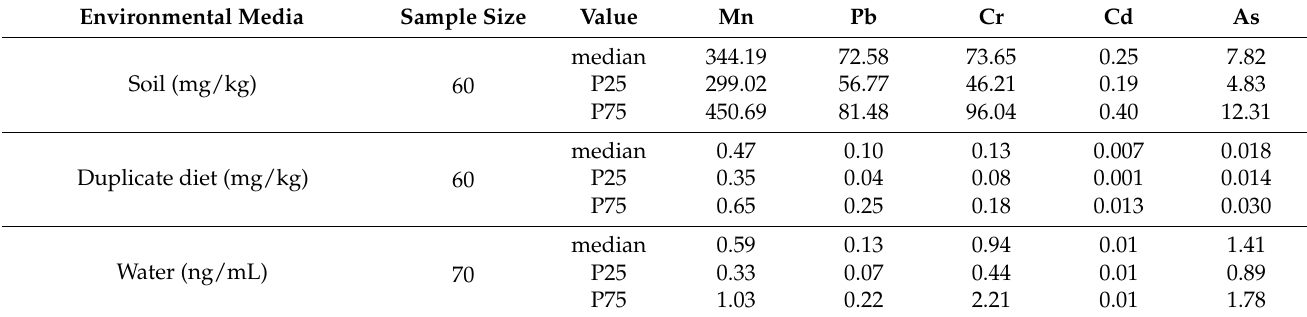
Table 2. Summary of the concentration of metal(loid)s in various environmental